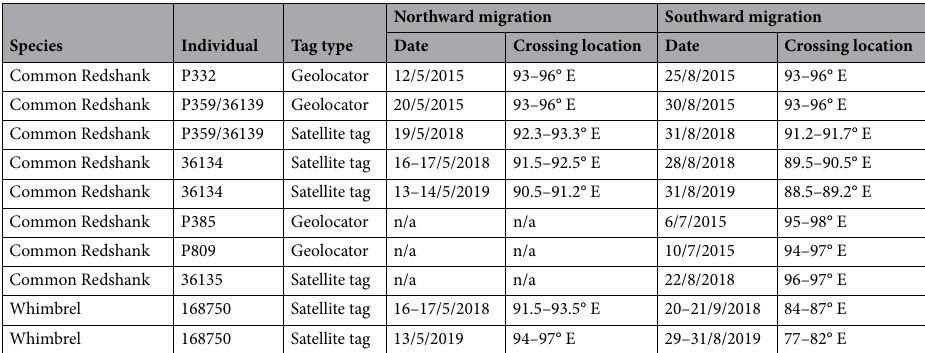
Table 1. Summary of date, time and location of Common Redshanks and Whimbrels tracked undertaking trans-Himalayan crossings. All dates are indicated by day/month/year. n/a not applicable.